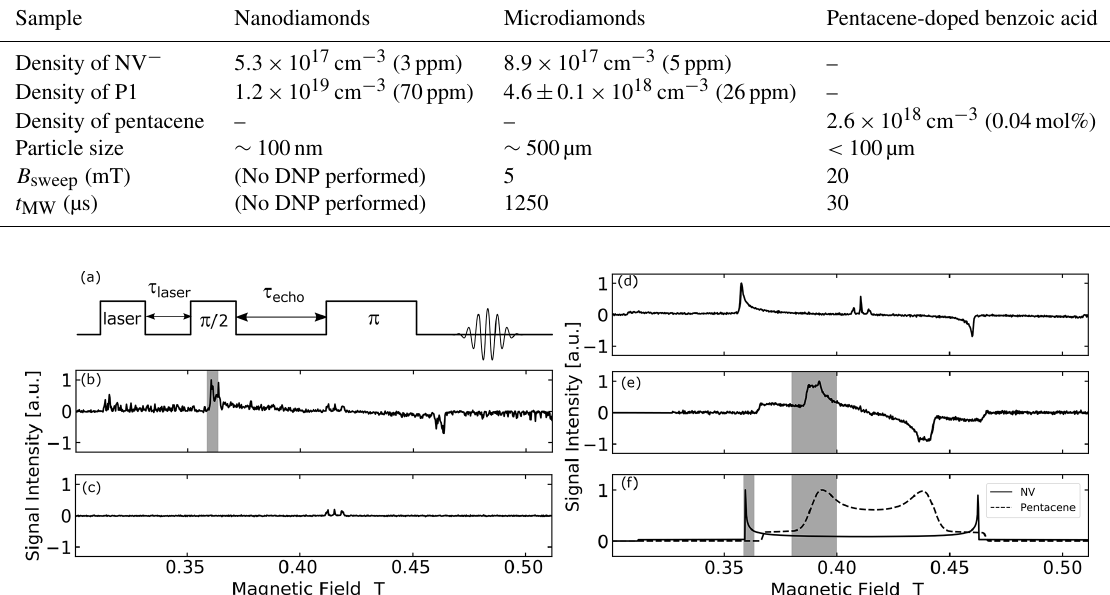
Figure 3. (a) EPR echo pulse sequence used in the measurement. τ laser is the delay time used for the lifetime decay measurement and τ echo is the echo time. (b–f) EPR spectra of polycrystalline samples under study obtained by experiment and simulation: (b) optically polarized EPR powder spectrum of microdiamonds with MW frequency of 11.63GHz. (c) EPR powder spectrum of microdiamonds with MW frequency of 11.63GHz without the laser pulse irradiation. (d) Optically polarized EPR powder spectrum of nanodiamonds with MW frequency of 11.52GHz. (e) EPR powder spectrum of powder BA doped with 0.04mol% pentacene with MW frequency of 11.66GHz. (f) Simulated EPR powder spectra of thermal state triplet electron in NV − center and pentacene at 11.6GHz. The shaded area is the magnetic field-sweep range B sweep for each